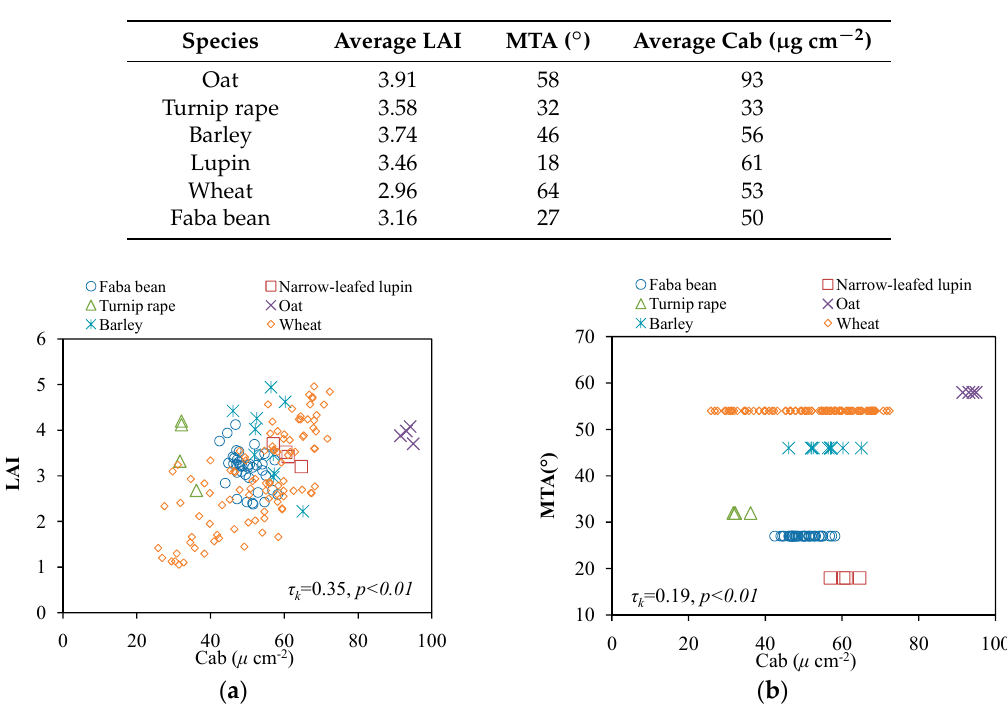
Table 3. Key characteristics of field plots measured in the study. LAI: leaf area index, MTA: mean tilt angle, Cab: chlorophyll a and b content.